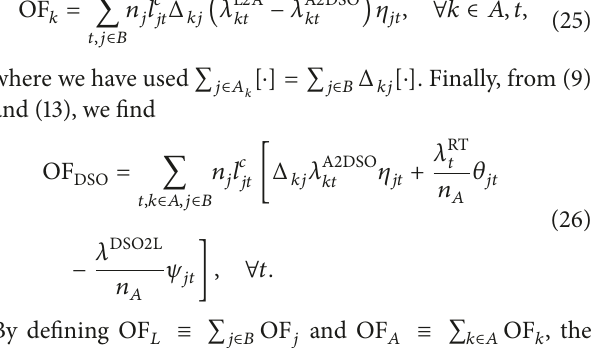
RT 𝑡 . The red dot repre-